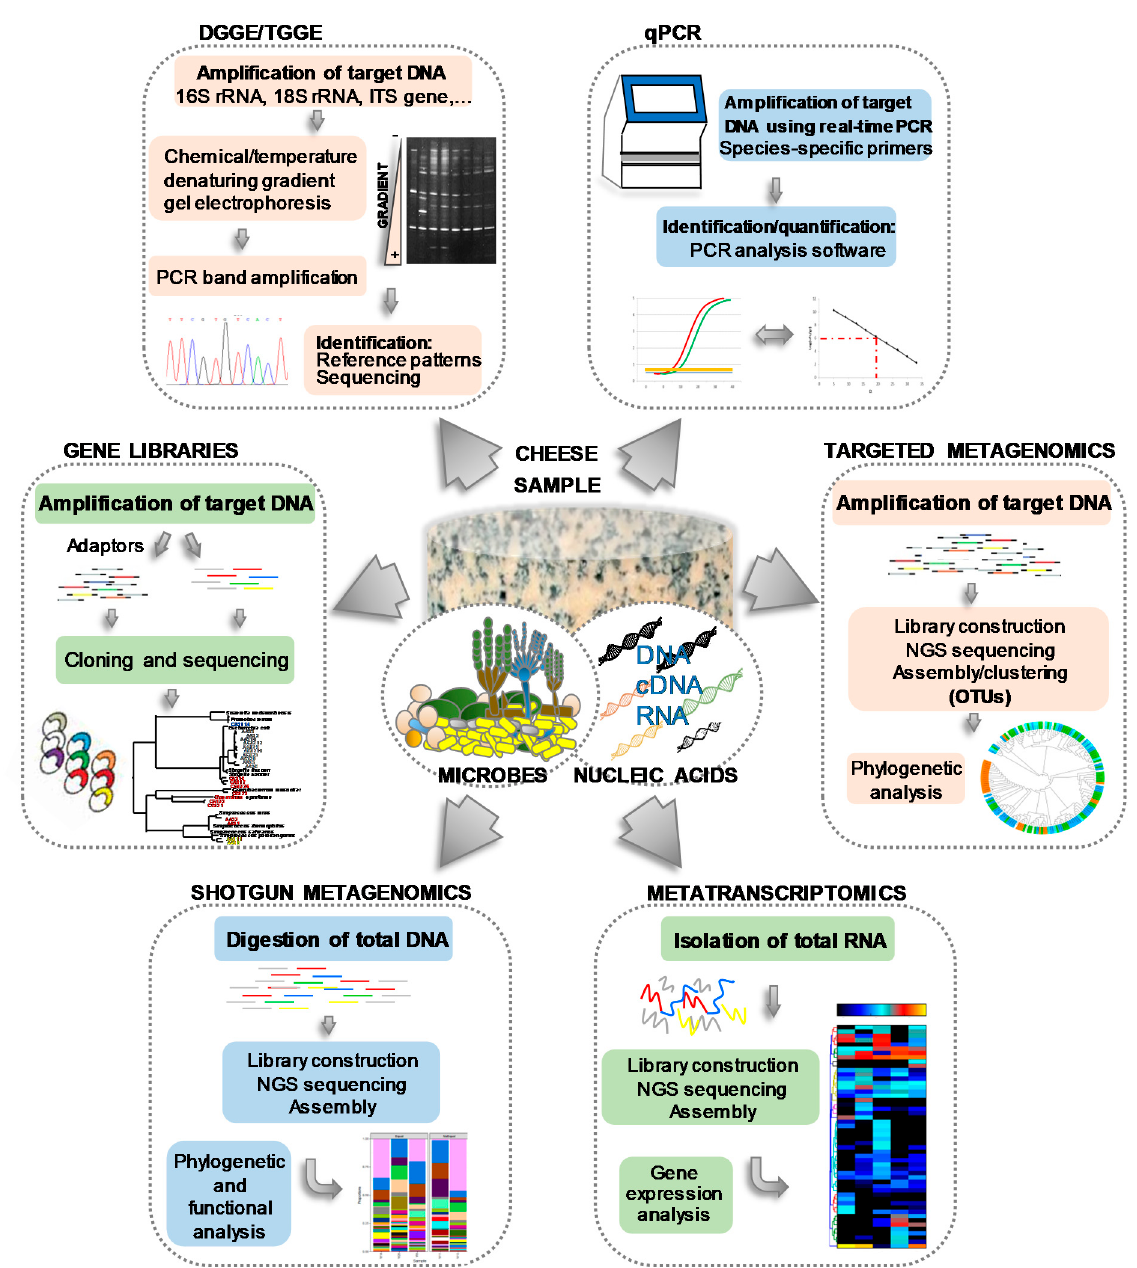
Figure 2. Flow chart of different microbial culture-independent molecular methods, including the main steps and final outputs, applied in cheese microbiology.